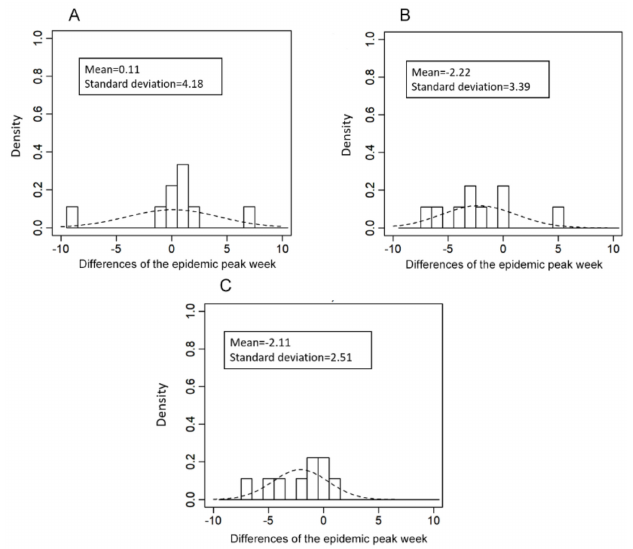
Figure 5. Distribution of the di ff erences between the week of peak incidence for two influenza virus types. ( A ) Comparison of the peak timing for influenza A / H1N1 versus A / H3N2 (peak epidemic week of A / H3N2 minus that of A / H1N1). ( B ) Comparison of the peak timing for influenza B versus A / H1N1 (peak epidemic week of A / H1N1 minus that B). ( C ) Comparison of the peak timing for influenza B versus A / H3N2 (peak epidemic week of A / H3N2 minus that of